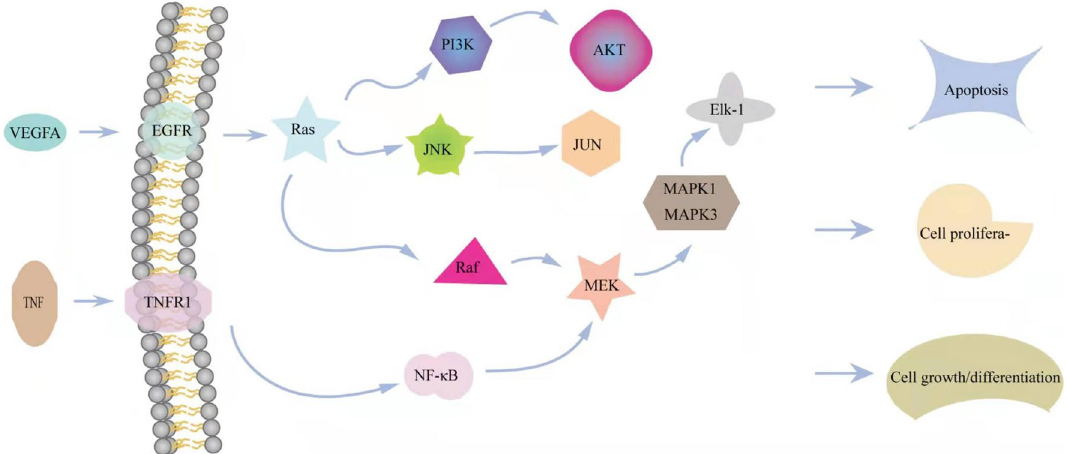
Figure 9. Components of MAPK signaling pathway influenced by